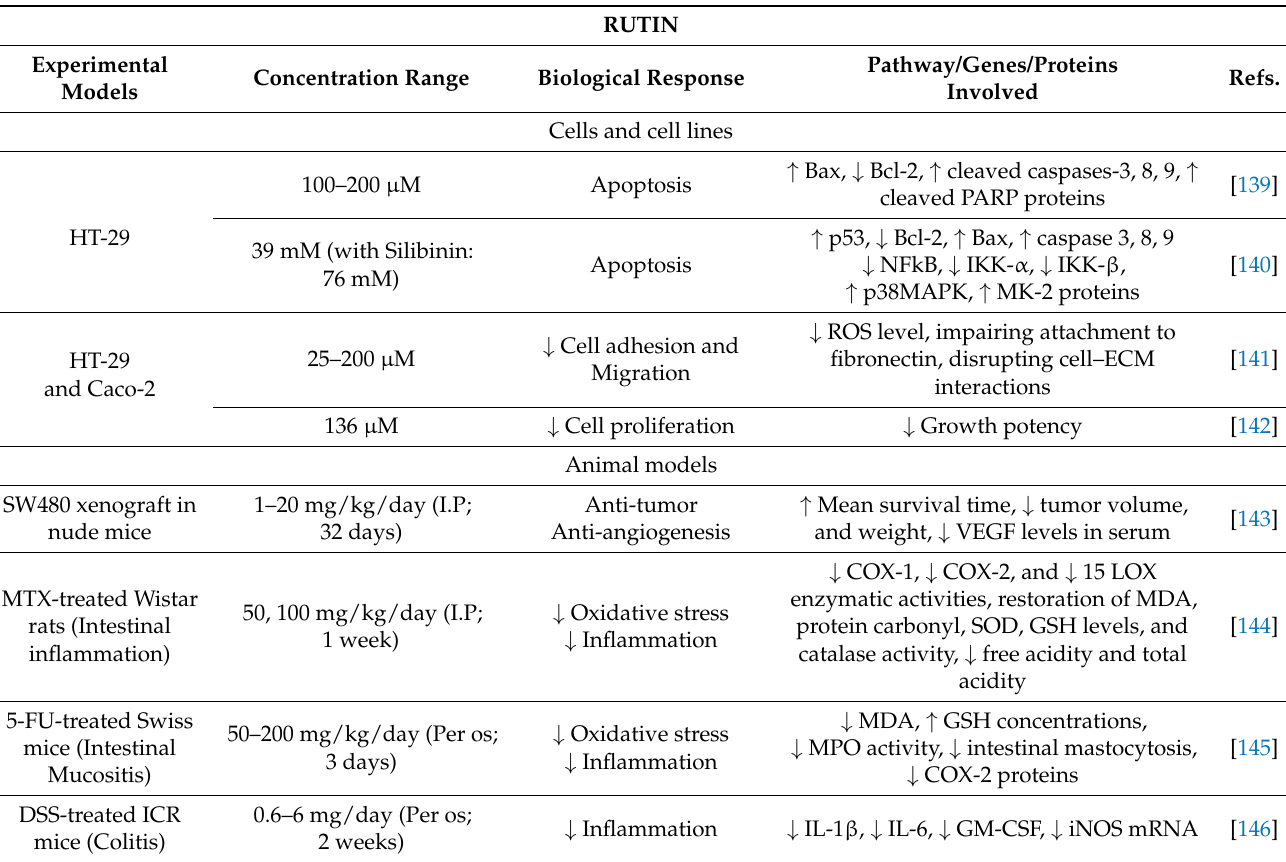
Table 8. Antitumoral effects of rutin in colorectal